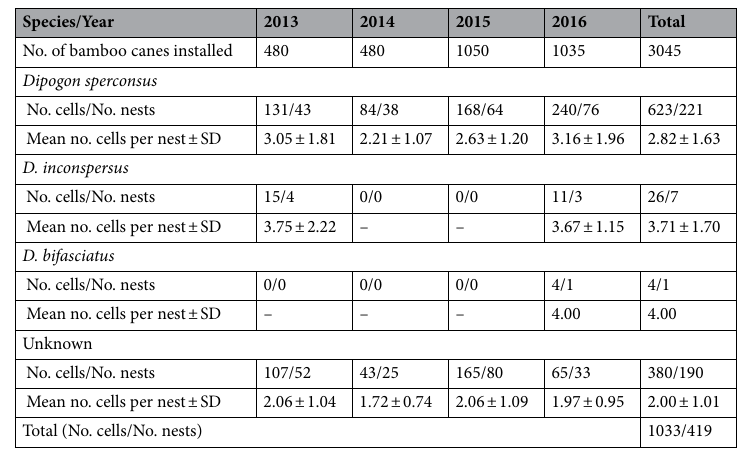
Table 1. The numbers of the collected nests and brood cells, and the mean number of cells per nest in three species of Dipogon ( Deuteragenia ).